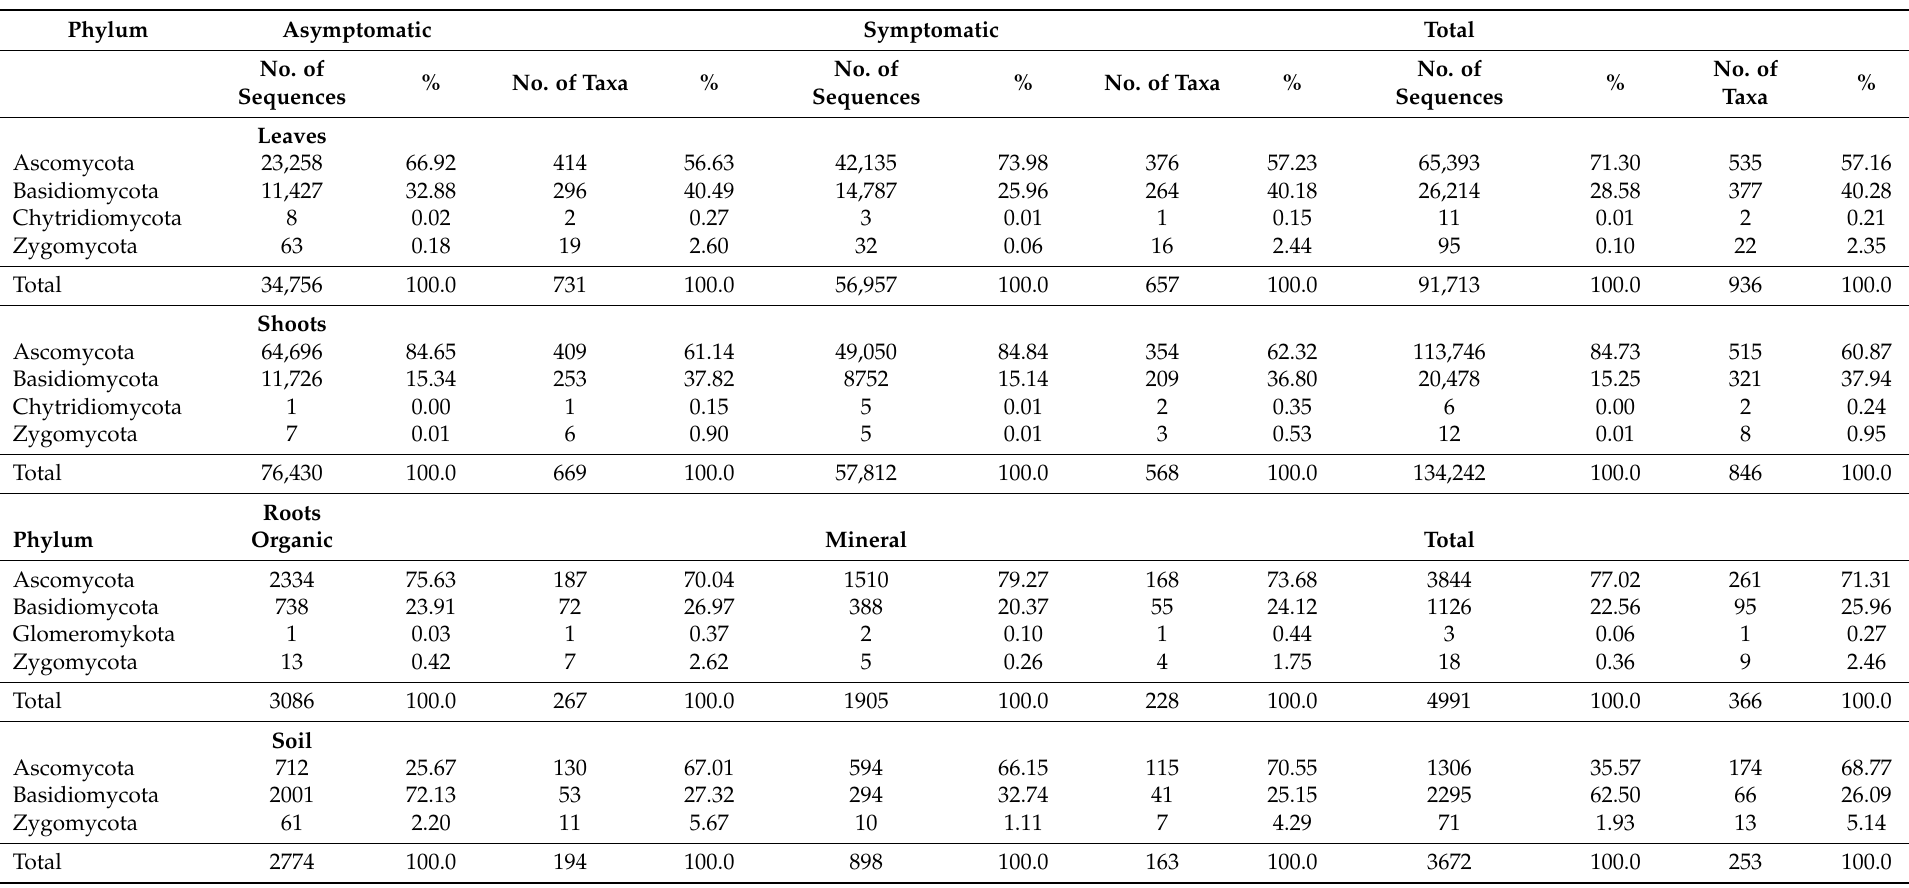
Table 2. Distribution of sequences and taxa, by phylum, in different types of samples of Fraxinus excelsior